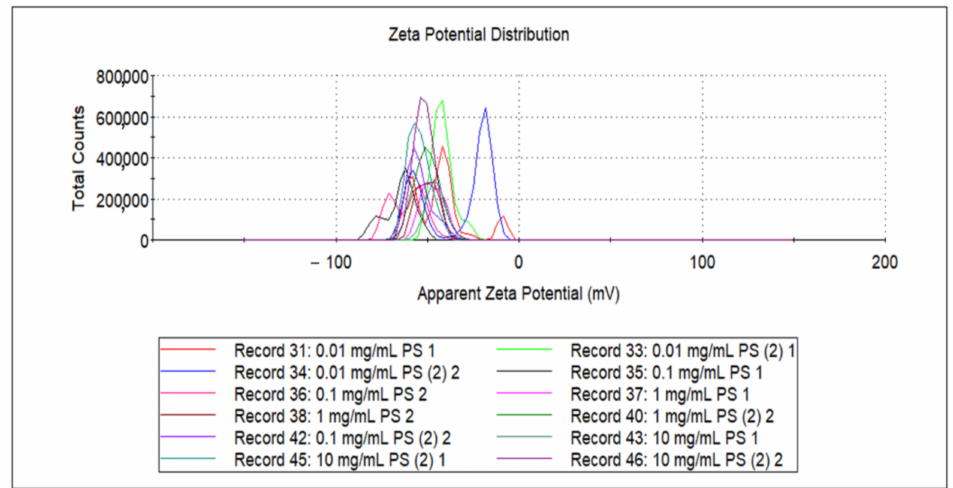
Figure 4. Zeta potential of PS samples at different